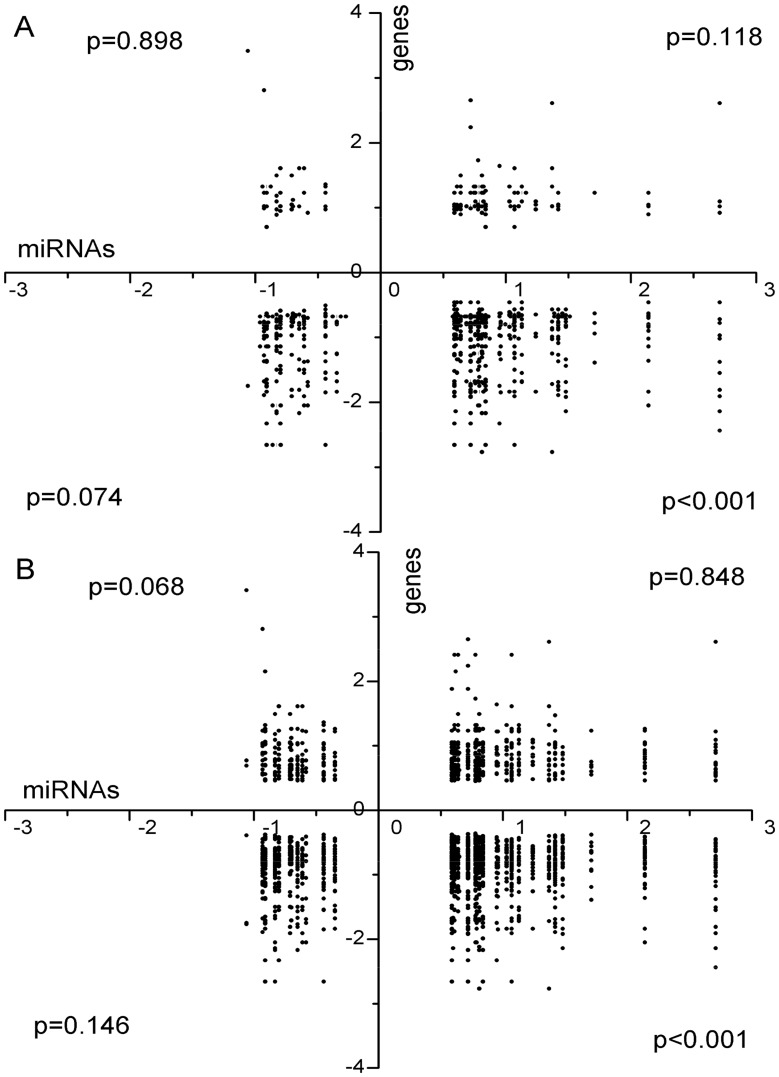
Targets of DEMs among DEGs.(A) Targets of DEMs included in DEGs list with FDR <5%; (B) Targets of DEMs included in the DEGs list with FDR <10%. Targets of DEMs were predicted by miRanda method. The target genes which were included in the DEGs were plotted. The x axis is log2 transformed fold change of DEMs, while the y axis stands for log2 transformed fold change of DEGs. The p-value was assessed by a two tailed chi-square test.